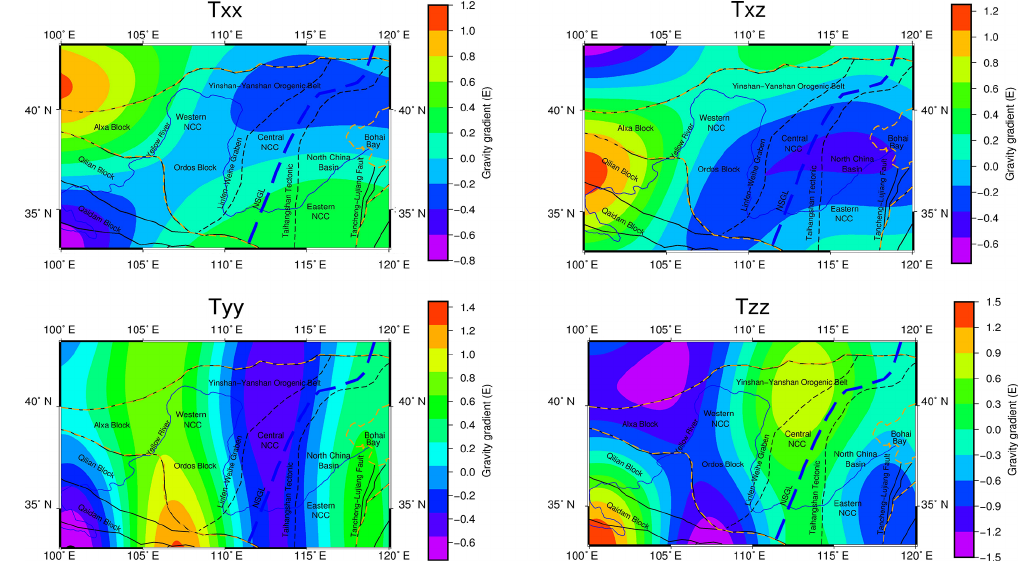
Figure 12. The gravity gradient effect ( T xx , T xz , T yy , T zz ) caused by the lithosphere under